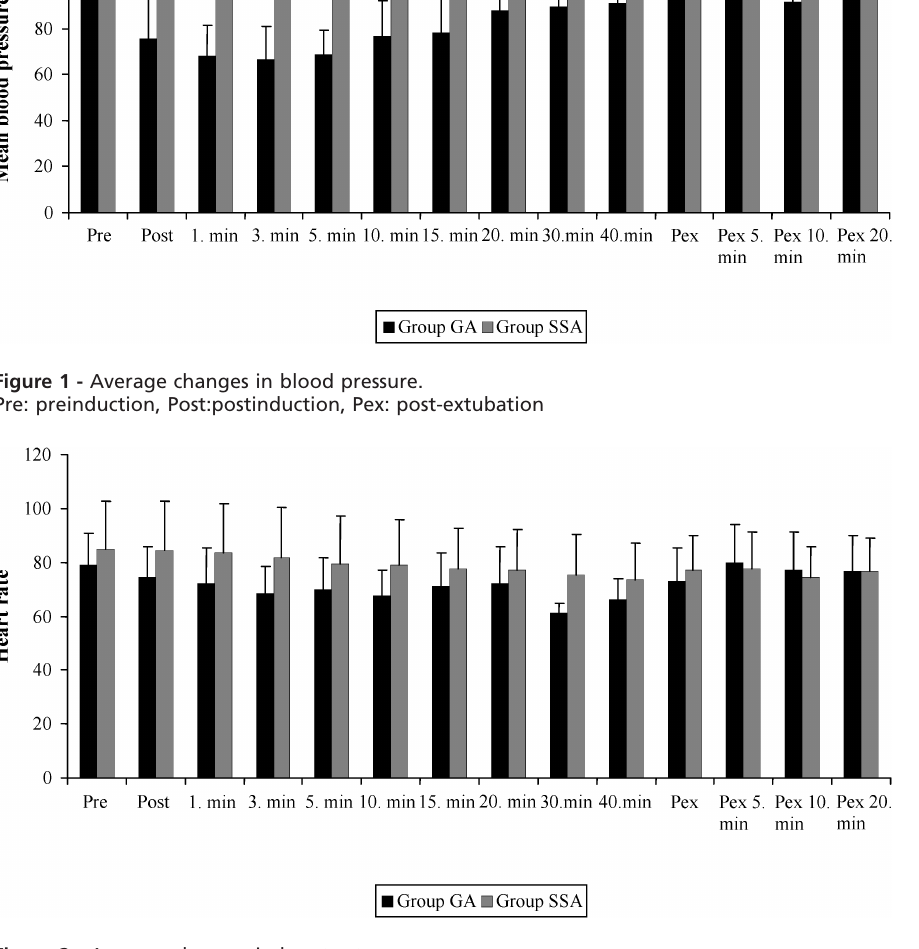
Figure 2 - Average changes in heart rate. Pre: preinduction, Post:postinduction, Pex: post-extubation